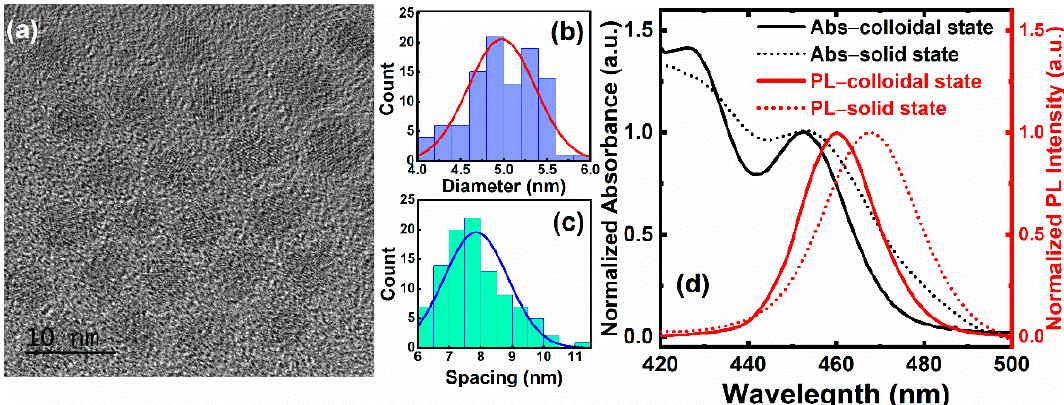
Figure 1. ( a ) High-resolution transmission electron microscopy (HR-TEM) of CdSe/ZnS–quantum dots (QDs). ( b ) Chart for particle size distribution. ( c ) Interparticle spacing (center to center) distribution of CdSe/ZnS–QDs by HR-TEM. ( d ) UV–Vis absorption and photoluminescence (PL) spectra of CdSe/ZnS–QDs in the colloidal state (toluene) and solid state (film).